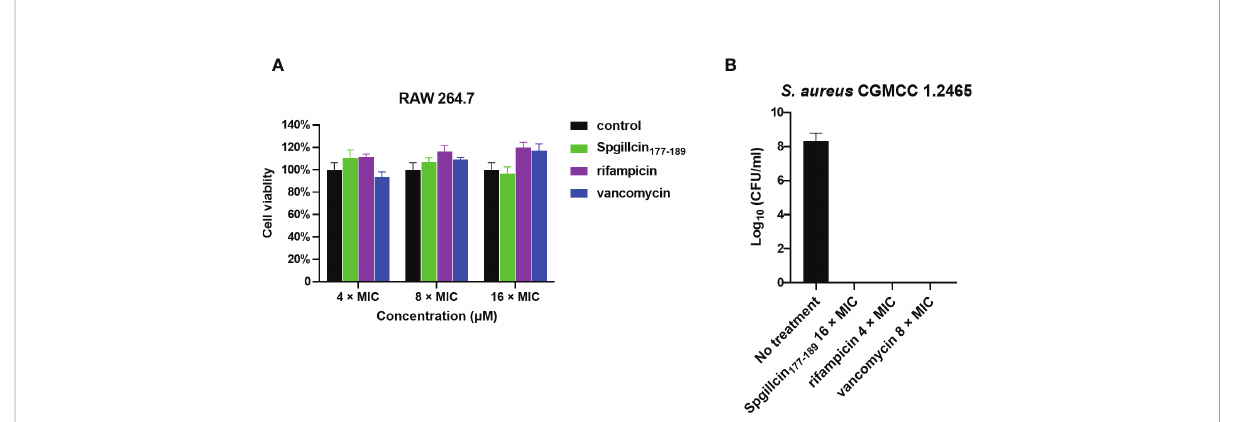
FIGURE 12 Spgillcin 177 – 189 eradicated extracellular S. aureus in the supernatant of RAW 264.7 cells. (A) The cell viability of RAW 264.7 cells was evaluated after different concentrations [4×, 8×, and 16× minimum inhibitory concentration (MIC); the MIC values of rifampicin and vancomycin against S. aureus were 0.01 and 0.25 m g ml -1 , respectively] of Spgillcin 177 – 189 or rifampicin or vancomycin treatment. RAW 264.7 cells were cultured in a medium without peptide/antibiotics as control. (B) Bacteria burden determination of S. aureus -infected RAW 264.7 cells after 24 h of using Spgillcin 177 – 189 (16× MIC) or rifampicin (4× MIC) or vancomycin (8× MIC) treatment.